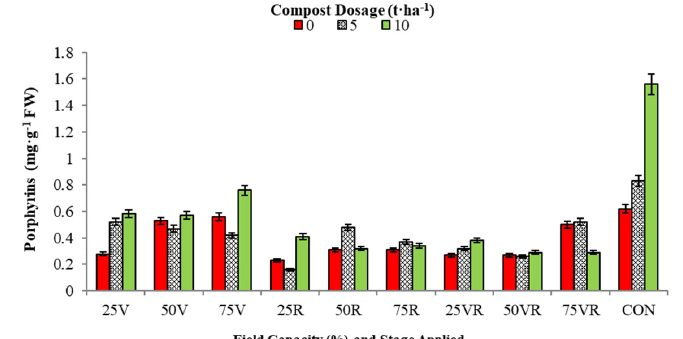
Figure 18. Effect of interaction of water regime, treatment stage and compost dosage on porphyrin content of okra leaf at 8 weeks The 25, 50 and 75% represent field capacity; V (vegetative), R (reproductive), and VR (vegetative and reproductive) represent the stage at which the deficit was applied. Data in the interaction analyzed with Least Squares Means, and means separated with